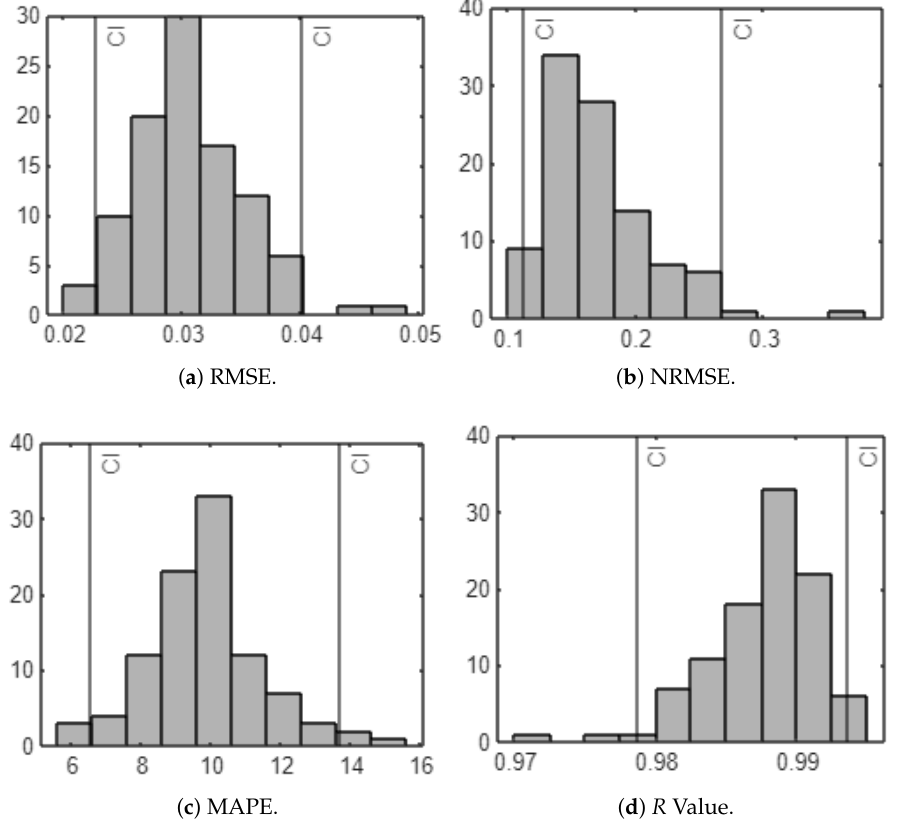
Figure 6. Histograms of the 95% confidence interval of surface resistance using the DT algorithm: ( a ) RMSE, ( b ) NRMSE, ( c ) MAPE, ( d ) R